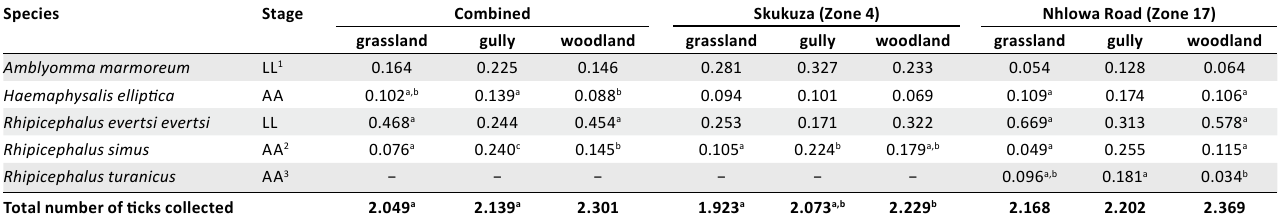
TABLE 2: Mean monthly tick collections [log